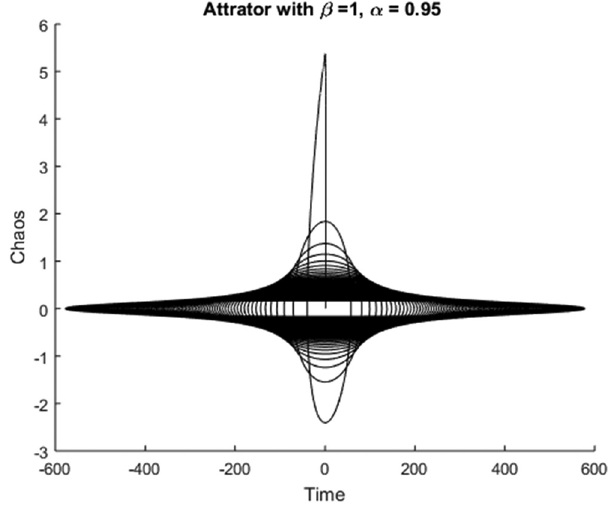
Figure 3: Chaos with the power - law case.